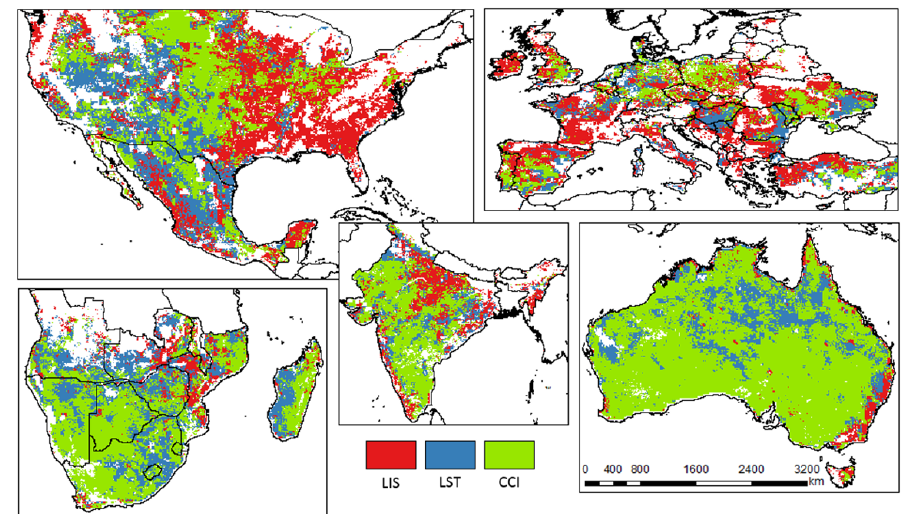
Figure 8. Maps representing the best performing (lowest error variance) dataset for each cell according to the TC analysis.